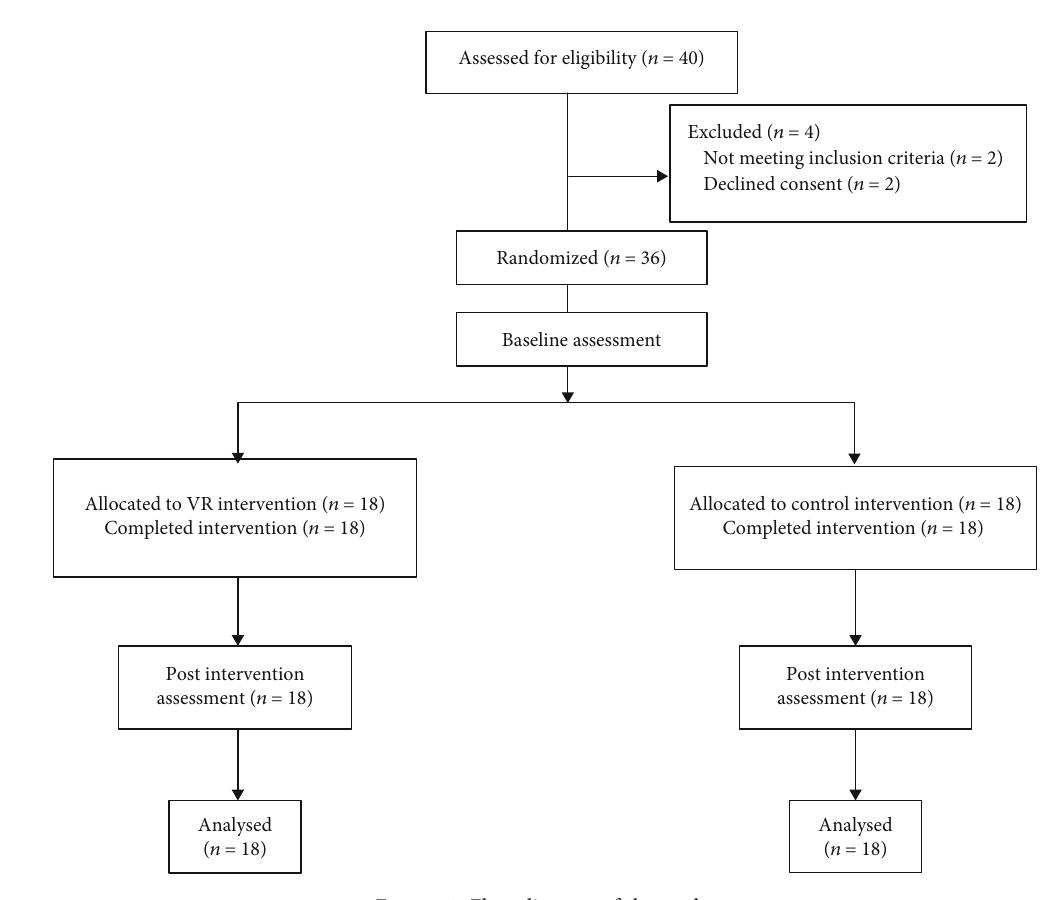
Figure 1: Flow diagram of the